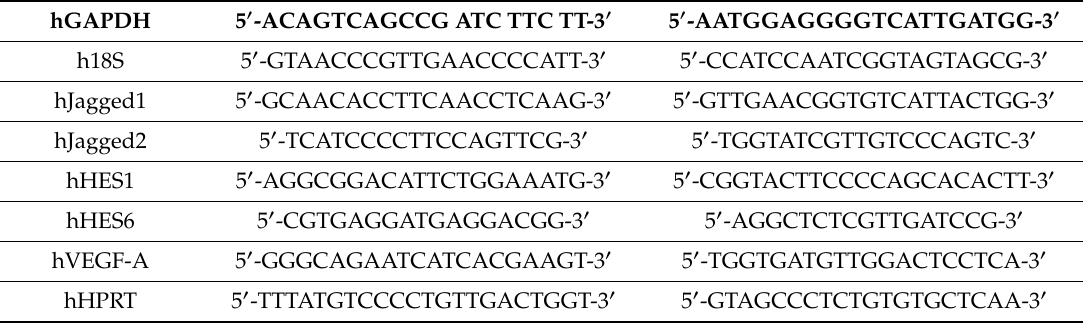
Table 2. Sequences of the primers used for the